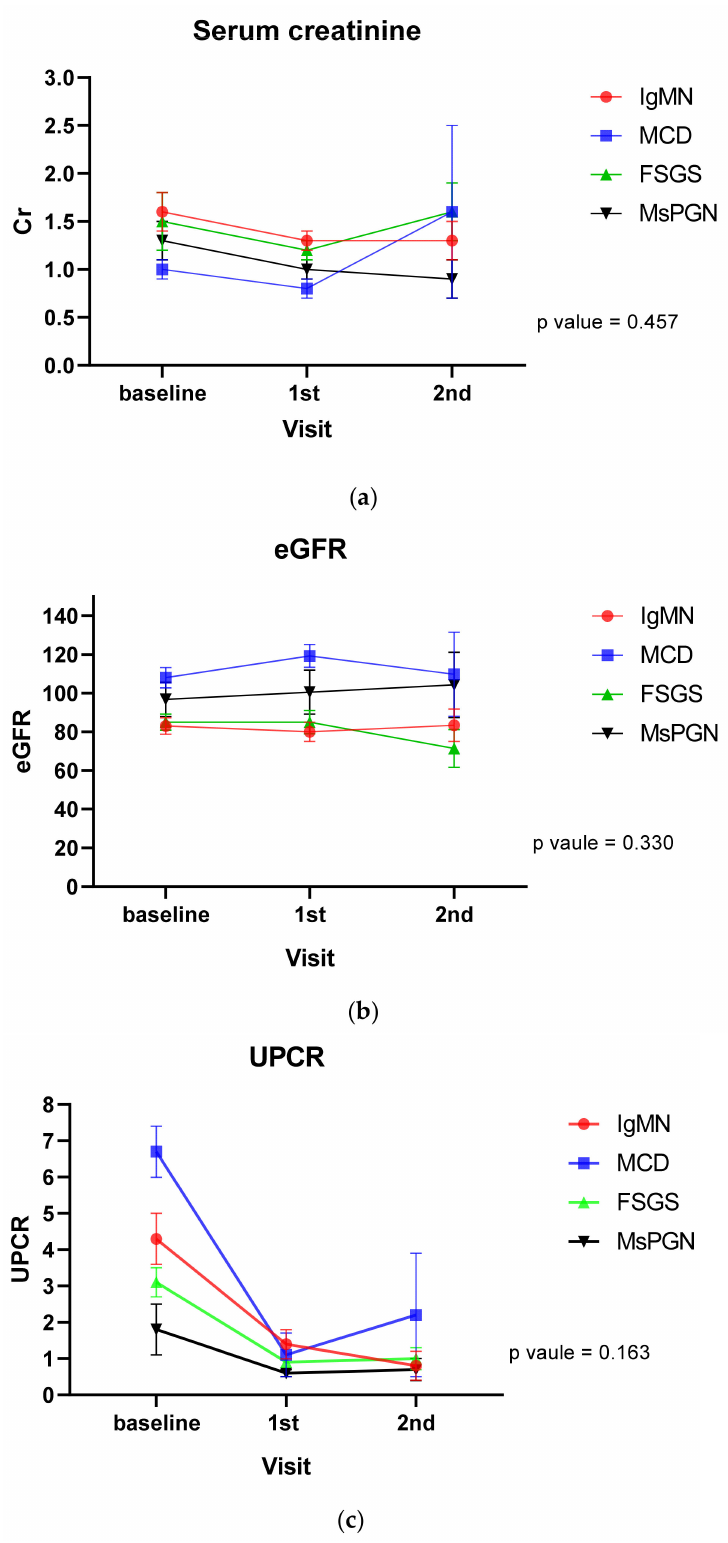
Figure 1. Time course of serum creatinine ( a ), eGFR ( b ) and proteinuria ( c ). eGFR, estimated glomerular filtration rate. The p value reflects both the time effect and the group effect. Cr, creatinine; FSGS, focal segmental glomerulosclerosis; IgMN, IgM nephropathy; MCD, minimal change disease; MsPGN, mesangial proliferative glomerulonephritis; UPCR, urine protein-to-creatinine